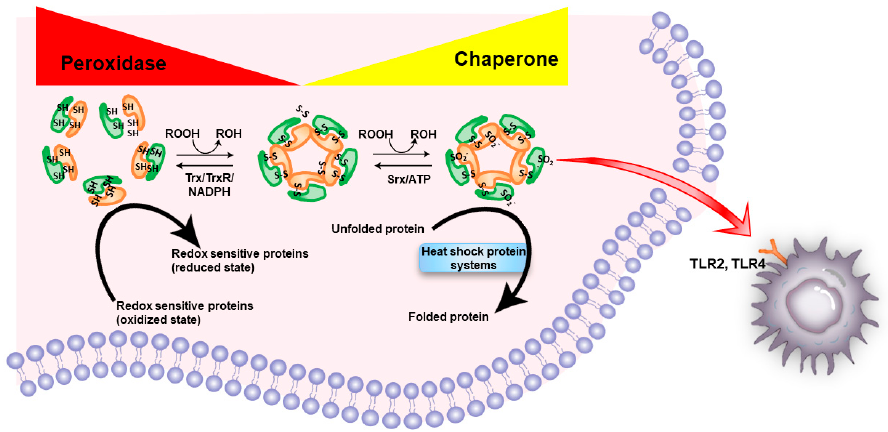
Figure 1. Schematic illustration of the general functions of peroxiredoxins. The highly conserved redox-sensitive cysteine residue (peroxidatic cysteine) in peroxiredoxin directly reduces various peroxide substrates (ROOH). A resolving cysteine can regenerate the peroxide reduction activity of the peroxidatic cysteine by thioredoxin (Trx)/thioredoxin reductase (TrxR)/nicotinamide adenine dinucleotide phosphate (NADPH) system. The peroxidase activity of peroxiredoxin can be easily inactivated by hyperoxidation of the peroxidatic cysteine to cysteine sulfinic acid (Cys-SO 2 - ). A spe- cial oxidoreductase sulfiredoxin (SRX) is required to restore the peroxidase activity of hyperox- idized peroxiredoxins by reducing sulfinic acid of peroxiredoxin back to thiol in an ATP-dependent manner. Interestingly, hyperoxidated peroxiredoxin is required for the recruitment of cytosolic mo- lecular chaperone HSP70 and disaggregase HSP104 to rescue misfolded proteins from aggregates. Extracellular peroxiredoxins function as DAMPs by triggering a proinflammatory response via binding to TLR2/TLR4 receptor. 4. Multiple Peroxiredoxins are Commonly Found in an Organism The importance of peroxiredoxins is reflected by their ubiquity and abundance. In budding yeast, there are five different peroxiredoxins [23]; in human and mouse, there are six different peroxiredoxins, respectively [24]. All of them show distinct but overlapping properties. Knockout or knockdown of individual peroxiredoxins in cells are often nonle- thal and yield relatively mild or even no phenotype under standard growth conditions [25]. Increases in the amount of oxidized DNA and carbonylated protein, and reduction in the growth and survival rates of the cells after oxidative insults were usually observed [26]. The effects of peroxiredoxin deficiency became more obvious upon deletion of mul- tiple peroxiredoxins and more prominent under-stress conditions [23,27]. For example, PRX1 KO mice have shorter lifespan, and developed age-dependent hemolytic anemias and various cancers [28]. PRX2 KO mice also have hemolytic anemia [29], but no cancer- related phenotype was reported. The amino acid sequence of mouse PRX1 and PRX2 pro- teins sharing 74% identity and 89% similarity and compensatory effects among the two peroxiredoxins were suggested. It was further assured by PRX1/PRX2 double knockout mice, which showed many novel abnormalities in addition to an aggravation of individual single knockout mice [30]. 5. From an Antioxidant Enzyme to a Redox Signaling Regulator It is generally agreed that the main function of peroxiredoxins is in defending against oxidative stress [23]. However, the antioxidant activity of peroxiredoxins is relatively weak [31]. For instance, it was observed that very low concentration of hydrogen peroxide (~100 μ M) was sufficient to inactivate human PRX1 [32]. Indeed, the peroxidase activity of peroxiredoxins can be easily inactivated by hyperoxidation of their peroxidatic cysteine under mild oxidative stress. A special oxidoreductase sulfiredoxin is required to restore